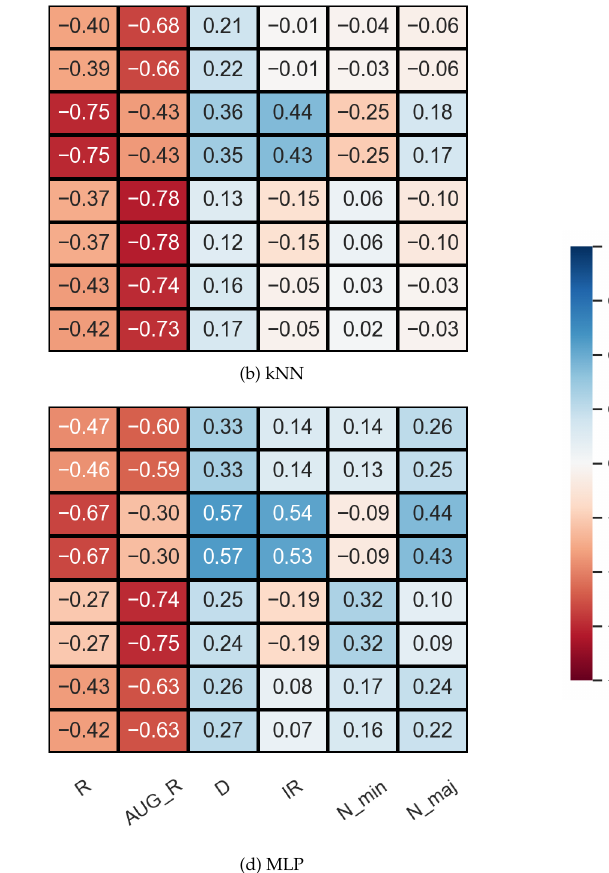
Figure 2. Result of the Spearman’s rank correlation test between some properties of the KEEL data set and the results of the classification combined with oversampling obtained on the data sets.